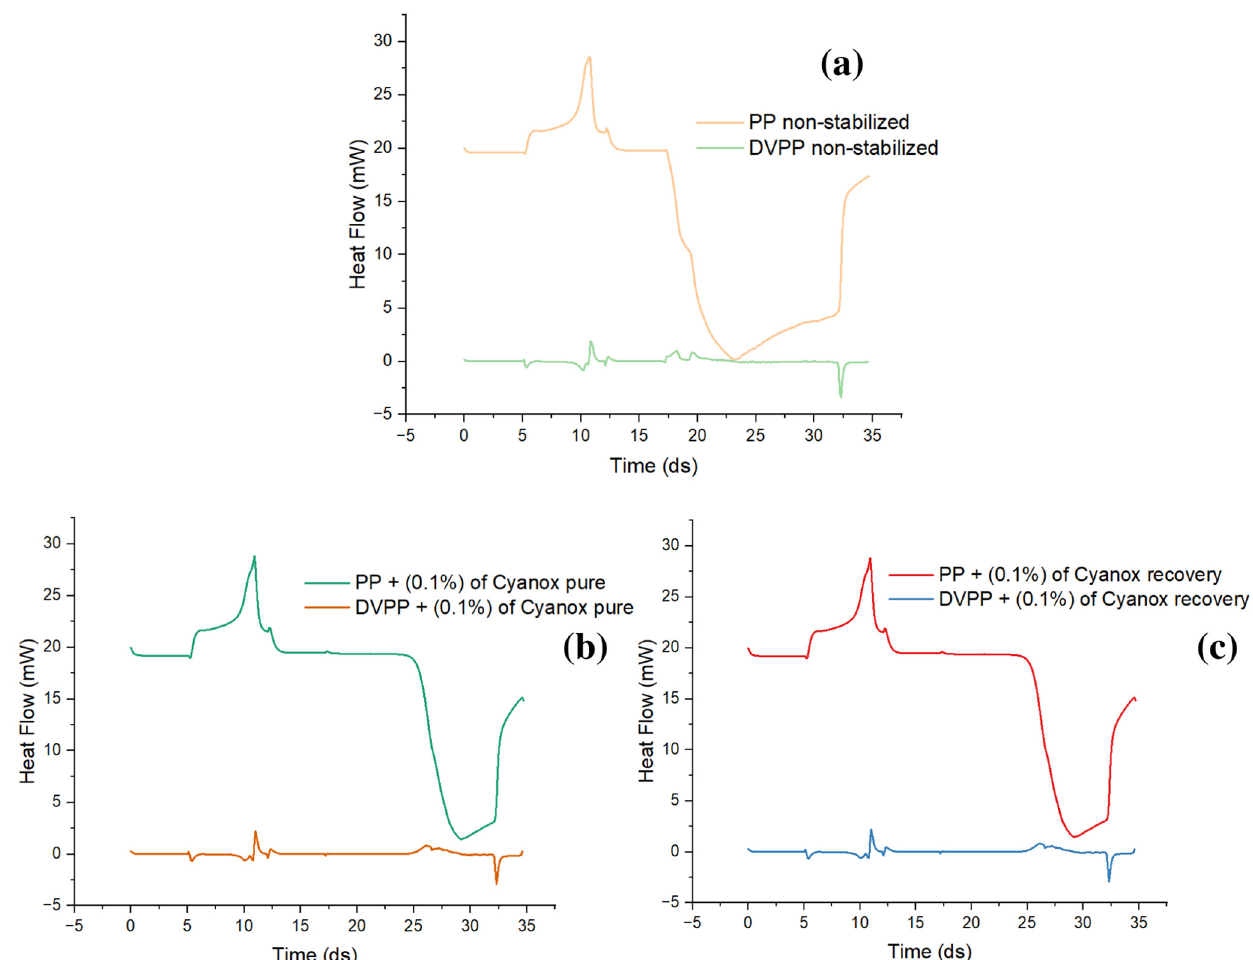
Figure 9. ( a ) Unstabilized PP oxidation induction time; ( b ) PP oxidation induction time with pure Cyanox 1790; ( c ) PP oxidation induction time with recovered Cyanox 1790.